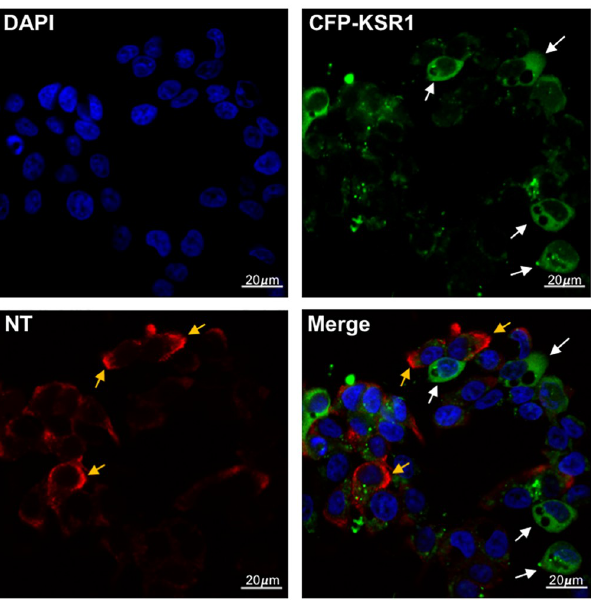
Fig 1. KSR1 expression stimulates NT release from BON cells. BON cells were transfected with pECFP-N-KSR1 (green) and labeled with immunofluorescent anti-NT antibody (red) and observed via confocal microscopy with 40x objective. White arrows indicate KSR1-positive cells, yellow arrows indicate NT labeling. Scale bar indicates 20 μ m.